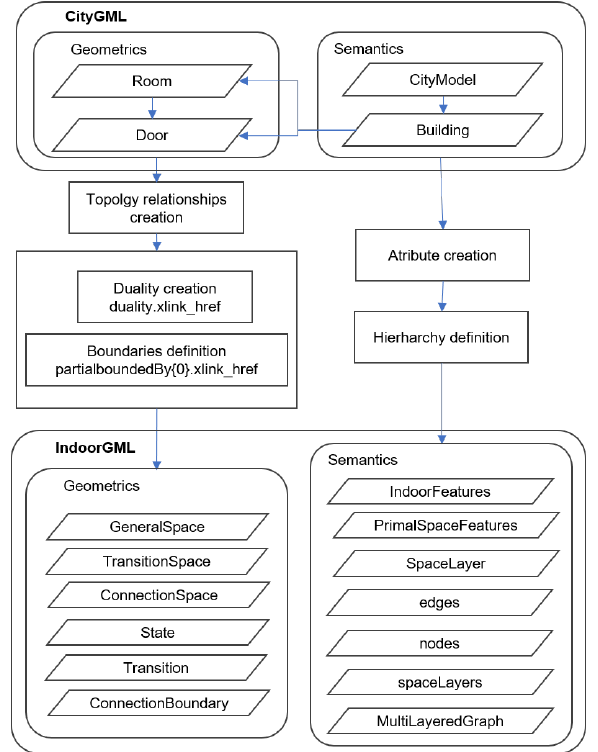
Figure 4. semantic workflow of the creation of the IndoorGML